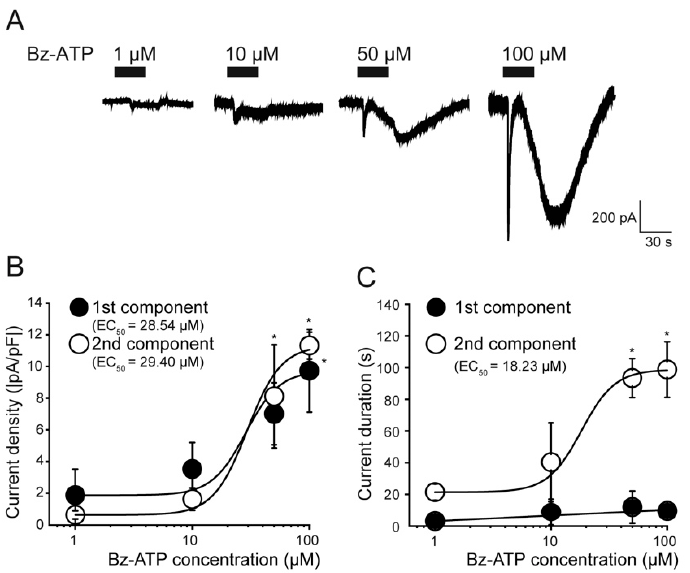
Figure 3. Dose-dependent relationships for current densities and duration of first and second components of the Bz-ATP-induced inward current. ( A ) Representative traces of inward currents induced by the application of four different concentrations of Bz-ATP (1–100 µ M) are shown. The applied Bz-ATP protocols are shown in the upper black boxes. ( B , C ) Showing the concentration- response relationships of applied extracellular Bz-ATP. Data points illustrate current densities ( B ) and durations ( C ) as functions of the applied concentration of Bz-ATP. Black circles represent the first component; white open circles indicate the second component of the biphasic inward current. Curves (solid lines) on the semilogarithmic scale were fitted according to the equation described in the text, except for the duration of the second component (which was fitted to a linear regression). Note that the current densities for the first component of the Bz-ATP-induced current in B (black circles) are identical to the data shown in Figure 2B. Each data point represents the mean ± SD of five separate experiments. Statistically significant differences between data points are indicated by asterisks. * p < 0.05.